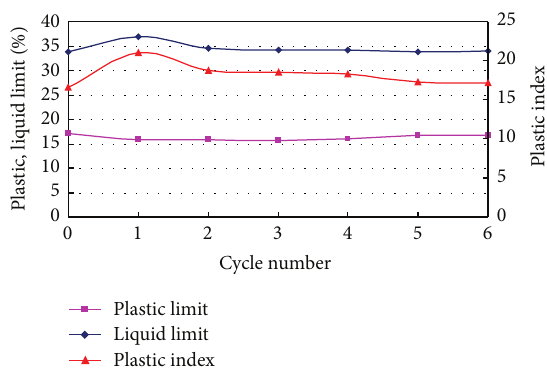
Figure 10: Variations in the plastic, liquid limit, and plastic index with cycle